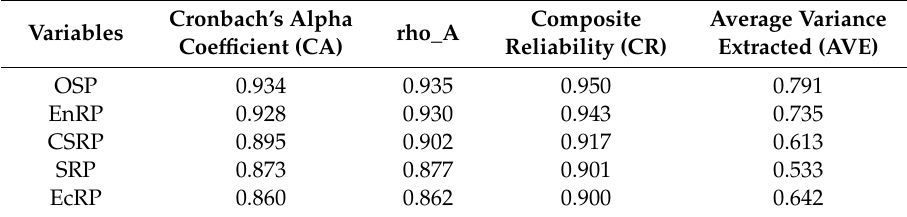
Table 4. Reliability and convergent validity check.